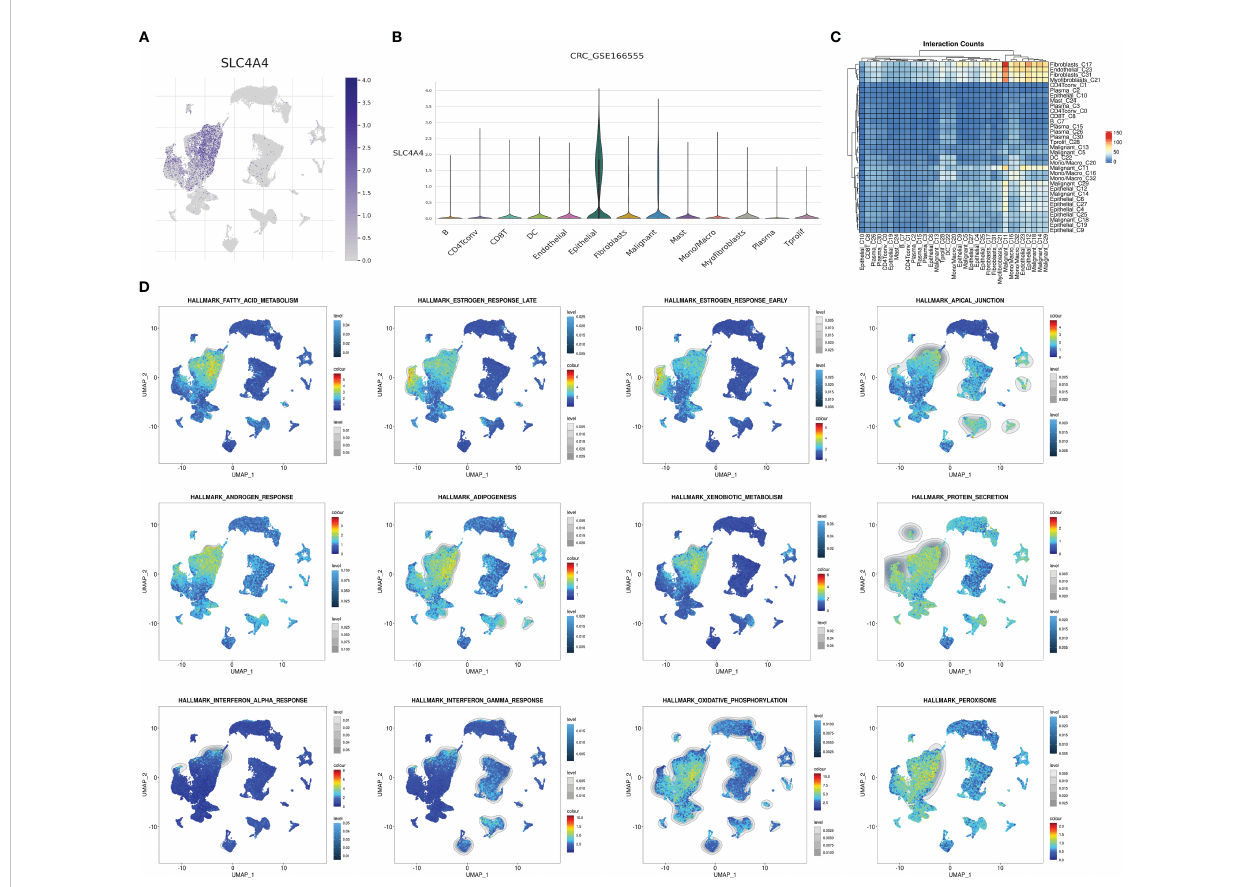
FIGURE 7 SLC4A4 is speci fi cally and highly expressed in epithelial cells. (A) The UMAP plot shows SLC4A4 expression in each cell type, (B) the violin diagram shows SLC4A4 expression in each cell type, (C) cell communication heat map, and (D) enrichment intensity and the fraction of different hallmark signaling pathways in each cell.